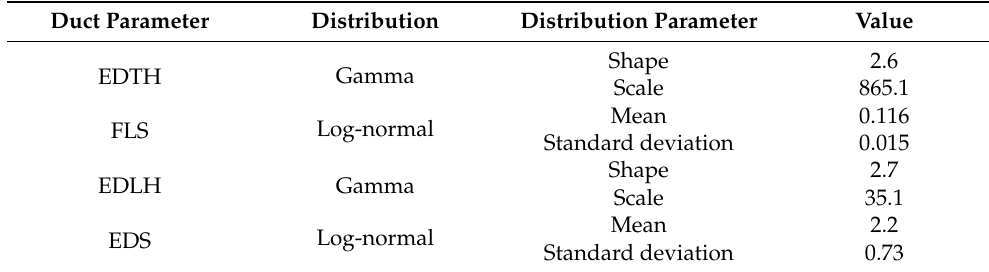
Figure 6. Parameter distribution and an atmospheric duct fitting distribution (the red line is the probability density curve and the blue line is the probability density curve obtained after fitting). Table 1. Parameter distribution table of an atmospheric duct.